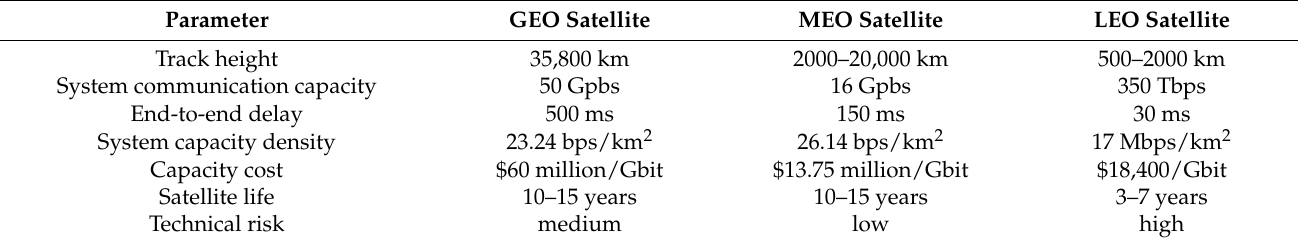
Table 1. Characteristics of satellite communication